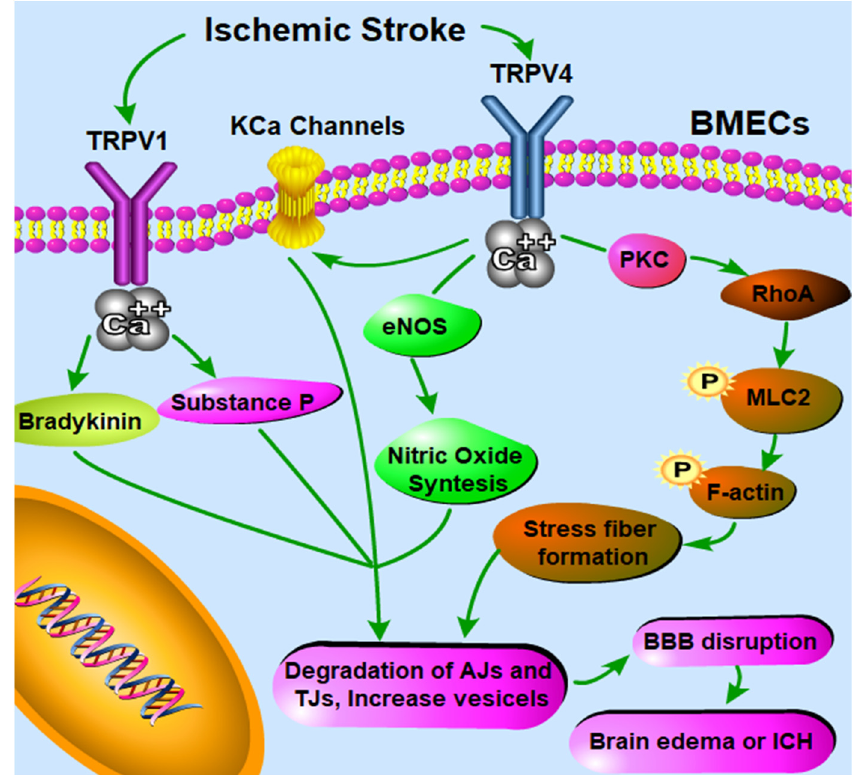
Figure 1. Schematic illustration describing the possible involvement of Transient Receptor Potential Vanilloid (TRPV) in the context of blood brain barrier (BBB) function under ischemic stroke according to current knowledge. TRPV1 antagonism can block bradykinin and Substance P release mediated BBB disruption during cerebral ischemia [62]. The mechanisms underlying TRPV4-mediated BBB permeability modulation are complex. Firstly, Ca 2+ influx, which is elicited by activation of endothe- lial TRPV4 channels, can further activate intermediate and small conductance Ca 2+ -sensitive K + (KCa) channels [114], while KCa channels have been well known to be able to induce BBB opening [115]. Secondly, increased intracellular Ca 2+ via TRPV4 activation can also significantly induce the endothe- lial nitric oxide synthase (eNOS) phosphorylation [105], and activated eNOS produces more nitric ox- ide (NO), further activating soluble guanylyl cyclase to produce more cyclic guanosine monophos- phate (cGMP); high concentrations of cGMP lead to an increase in the number of pinocytic vesicles containing caveolin-1 and caveolin-2 and BBB permeability [116]. Thirdly, another possible mecha- nism involved in TRPV4 activation mediated BBB disruption is the formation of stress fibers through the PKC α /RhoA/MLC2 pathway activation. PKC α activation has been involved in TRPV4- regulated endothelial cell permeability alteration [117]. After activation, PKC α can directly interact with RhoA, leading to the rearrangement of the cytoskeleton [118,119]. RhoA further binds to Rho- kinase, which can strongly induce the phosphorylation of myosin light chain 2 (MLC2) and the for- mation of actin stress fibers [120], thus leading to BBB disruption [121]. Therefore, TRPV4 antagonism is able to inhibit actin stress fibers formation in ischemia, thus preserving/rescuing the integrity of the BBB [101].